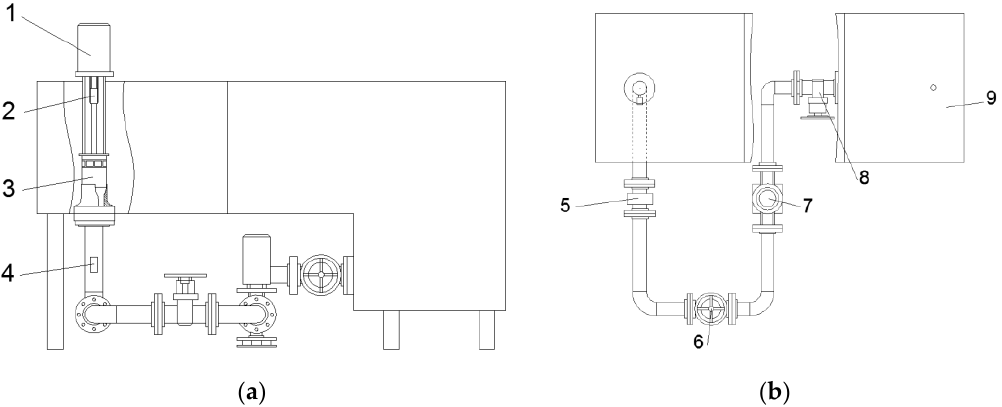
Figure 4. Experimental setup: ( a ) left view; ( b ) top view. (1. Motor 2. Torque measuring instrument 3. Test model pump 4. Pressure gauge 5. Flow meter 6. Gate valve 7. Auxiliary pump 8. Gate valve 9. Water tank).